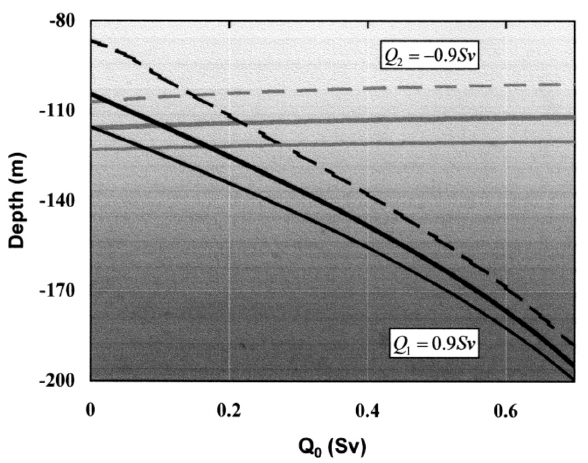
dependence on Q is better illustrated in Figure 5 2 (grey lines), which is the counterpart of the black lines on the same figure with Q playing the role of 2 Q . If the outflow is constant, the interface remains 1 almost motionless for a wide range of values of Q 0